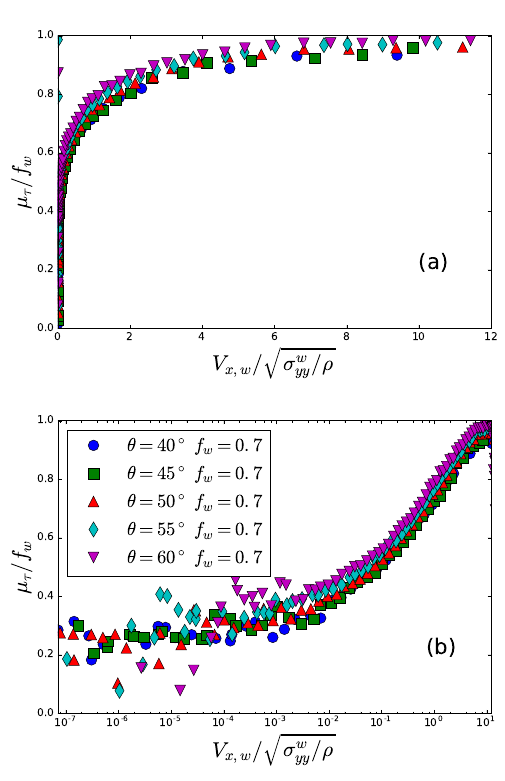
Figure 3. The e ff ective friction coe ffi cient on sidewalls, µ τ , is strongly influenced by confinement. In the vicinity of the free surface, it is close to the grain-sidewall friction coe ffi cient, f w Then, it weakens and, in the creep zone, reaches a constant value.